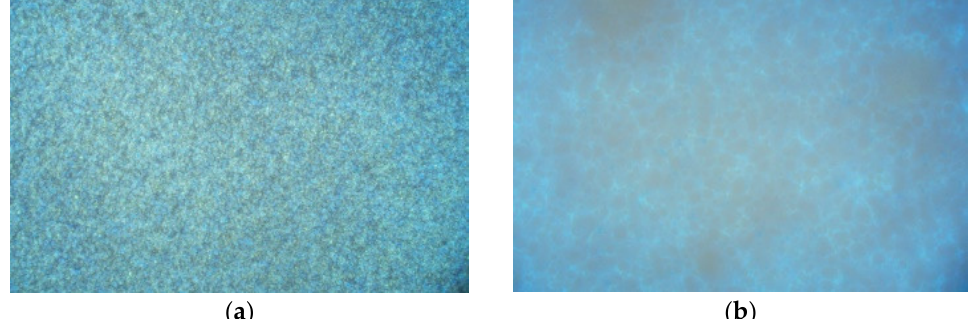
Figure 7. Fluorescent micro-structure of WE/A with 10% WER ( a ) 1 h; ( b ) 48 h.